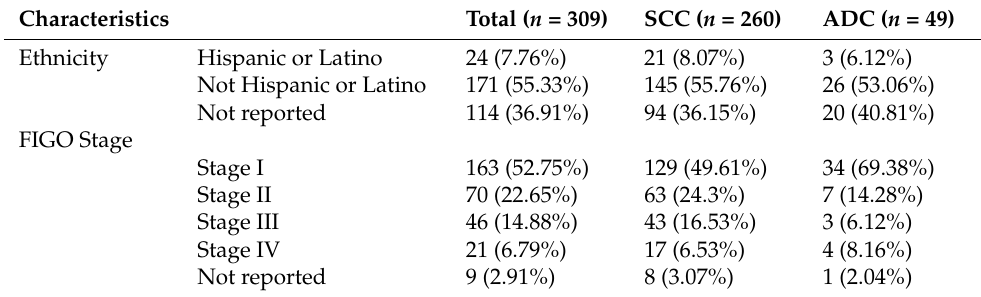
Table 1. Clinical characteristics of the TCGA